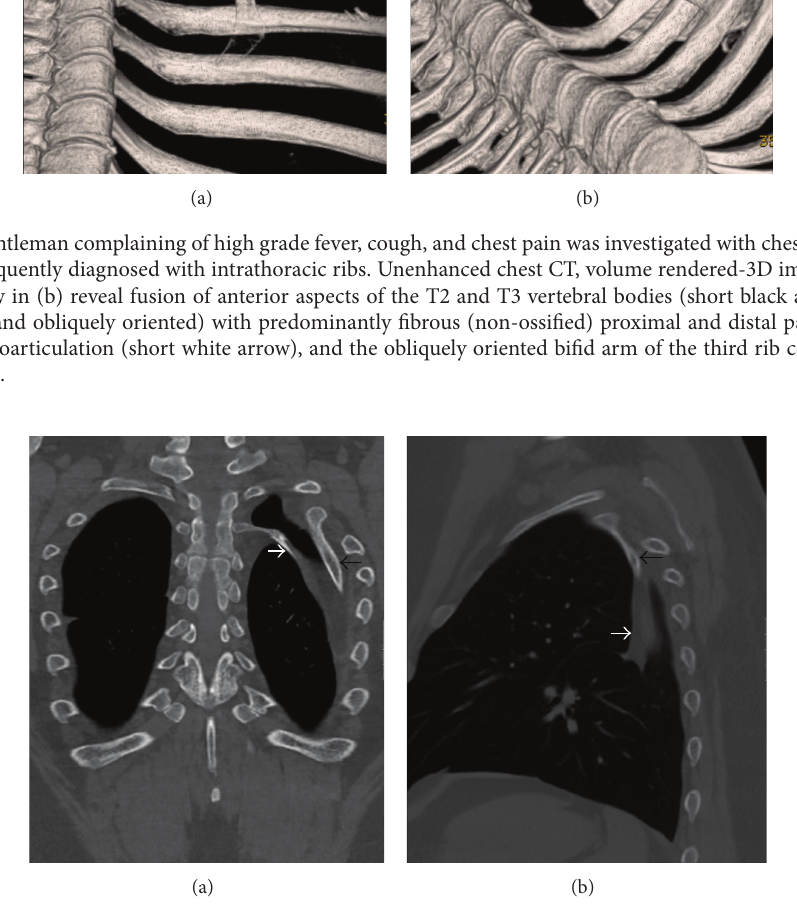
Figure 4: 43-year-old gentleman complaining of high grade fever, cough, and chest pain was investigated with chest radiographs and helical chest CT scan and subsequently diagnosed with intrathoracic ribs. Unenhanced chest CT (coronal MIP reformatting, bone window) image in (a) shows left second supernumerary (white arrow) and left third bifid (black arrow) intrathoracic ribs, prominent extrapleural soft tissue around these ribs, and hypoplastic left lung. Unenhanced chest CT (sagittal MIP reformatting, bone window) image in (b) shows left third bifid intrathoracic rib (black arrow) and prominent extrapleural soft tissue around it (white